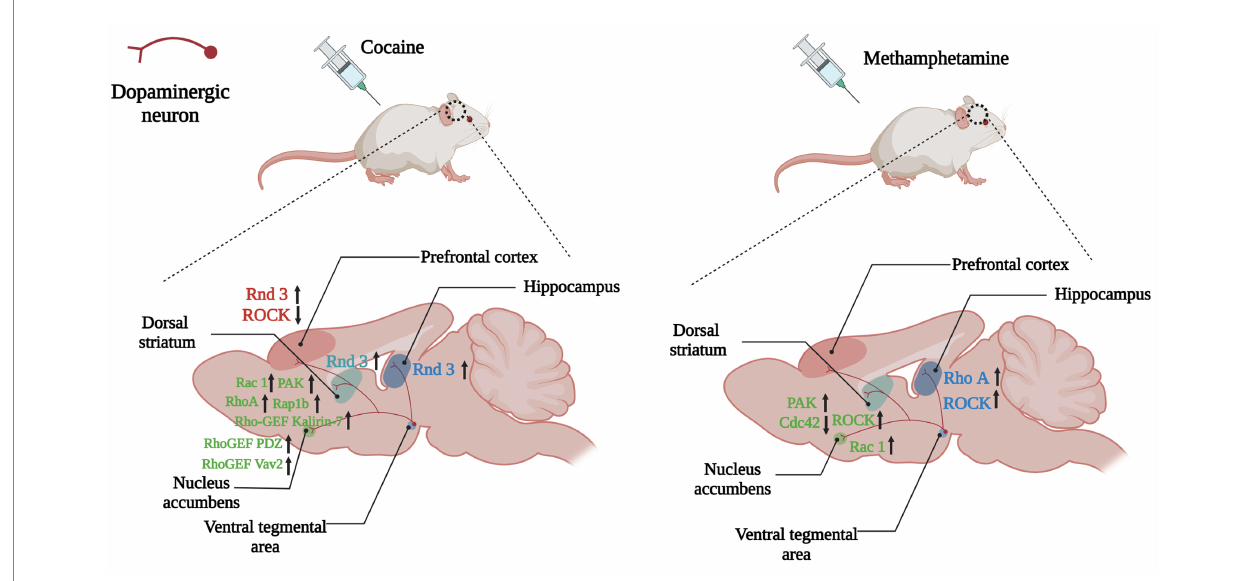
FIGURE 5 Changes of Rho GTPases expression in brain induced by psychostimulants. Dopamine plays a role in the brain’s reward system, helping to reinforce certain behaviors that result in reward. Dopaminergic neuronal projections from the ventral tegmental area (VTA) to the nucleus accumbens, dorsal striatum and hippocampus, and prefrontal cortex underlie the neurobiology of this process. Psychostimulants such as cocaine and amphetamine lead to abnormal expressions of Rho GTPases (Rho A, Rac1, Rnd3) and their regulators (Kalirin-7, Vav2) in the above regions, which take part in the reinforcement, withdrawal and relapse of psychostimulants addiction. Arrows are used to represent changes in Rho GTPases and their regulators in different brain regions caused by addictive substances, with upward arrows indicating increased expression and downward arrows indicating decreased expression. The color of the Rho GTPases and their downstream molecules coincides with the color of the brain regions in which they are differentially